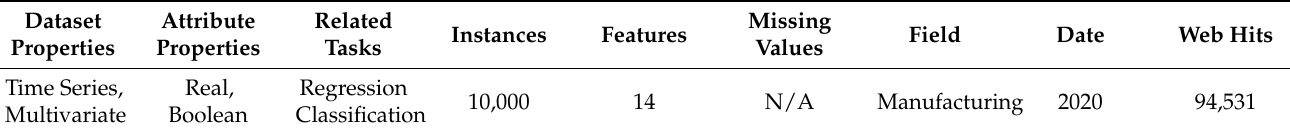
Table 1. Dataset